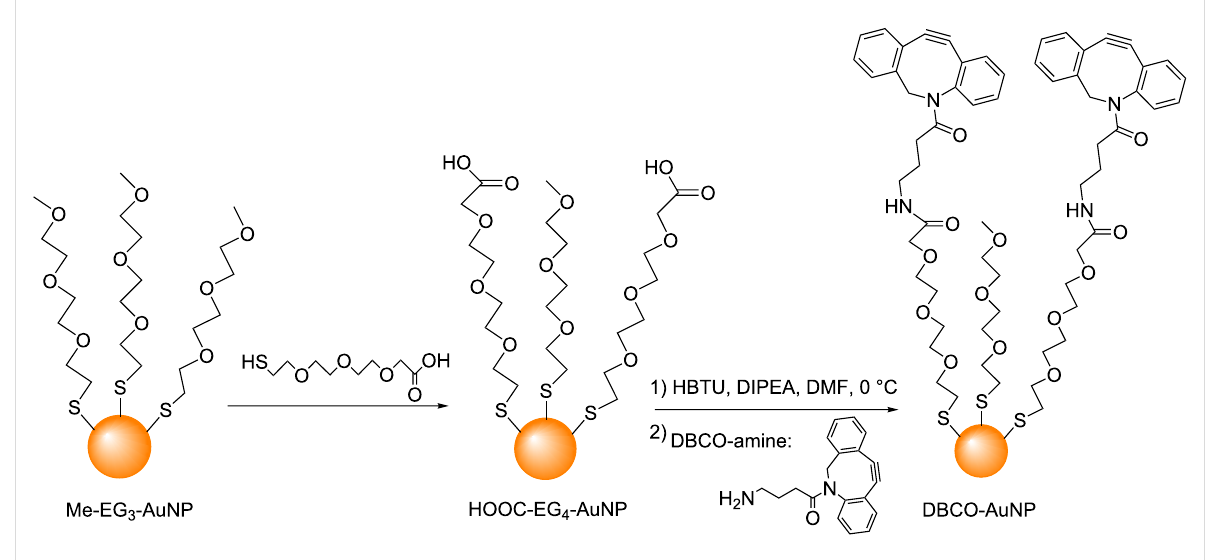
AuNPs with a DBCO-amine then yielded the